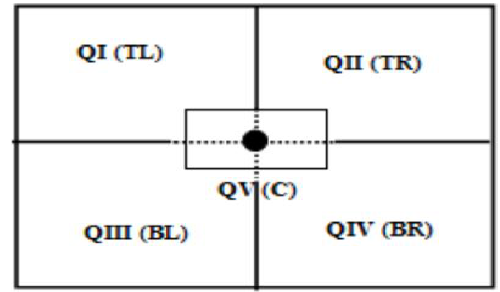
Figure 5: Selection of one eye image Ip and manual classifica- tion in five defined quadrants for creating